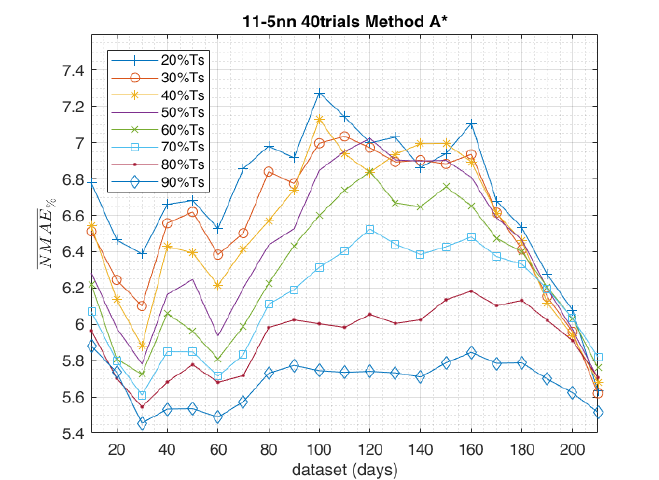
Figure 13. NMAE % as a function of the dataset size.